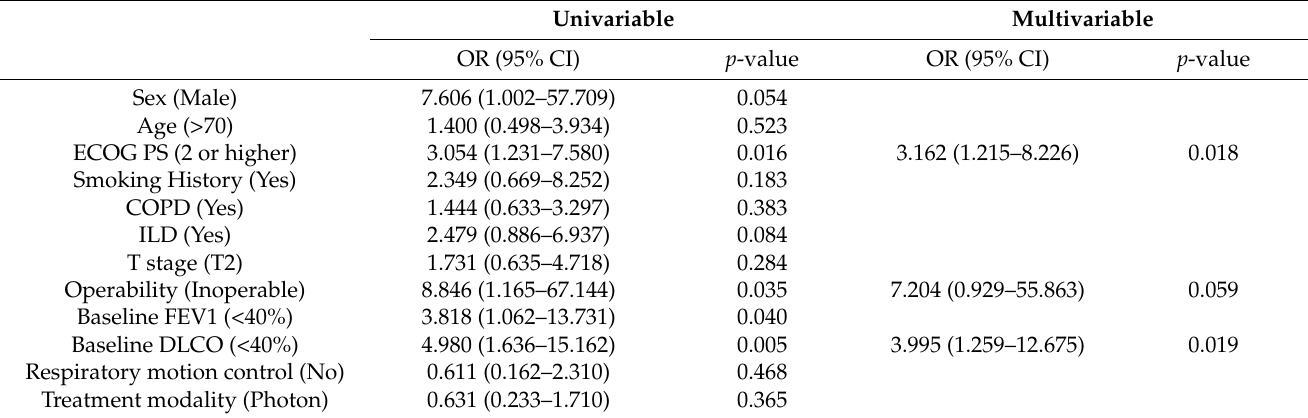
Table 4. Univariable and multivariable binary logistic regression analysis for grade 3 or higher radiation